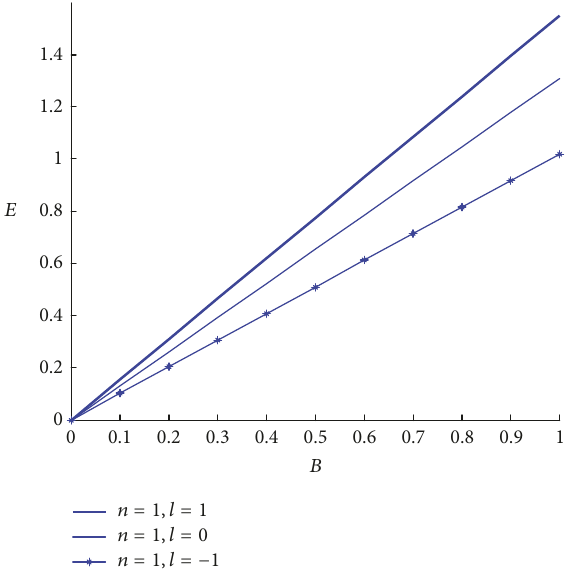
Figure 3: The energy eigenvalues versus 𝐵 ( 𝑚 = 1